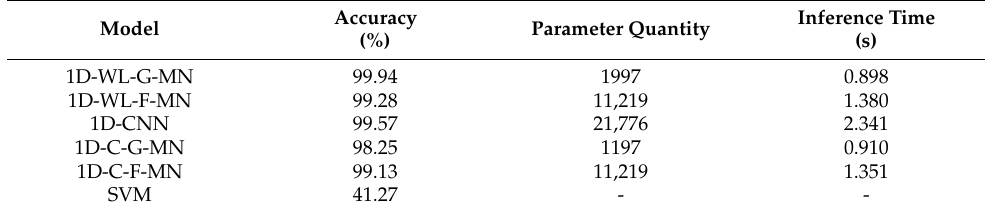
Table 5. Performance comparison of different models.